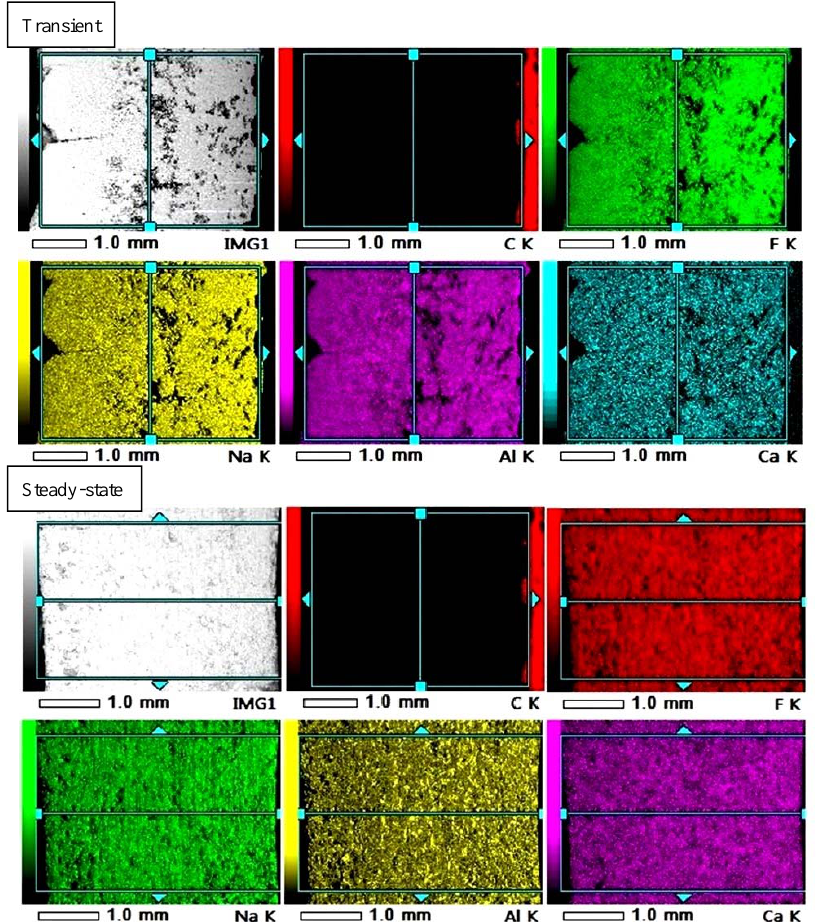
Figure 6. Distribution of the elementary chemical composition on the surface of transient ( top ) and steady ‐ state ( bottom ) samples using SEM ‐ BSE mapping technique.